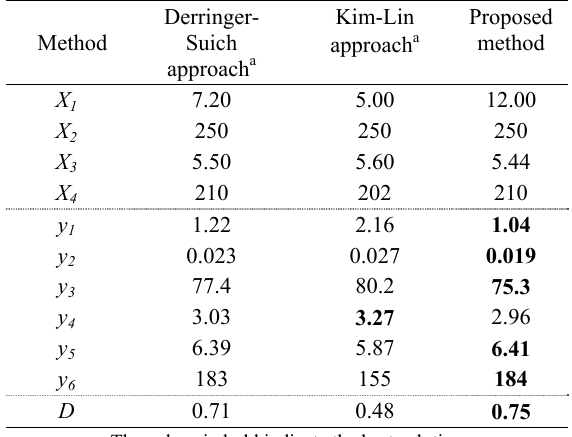
Table 18. Comparison of results for example 3: Methods from literature and approach proposed